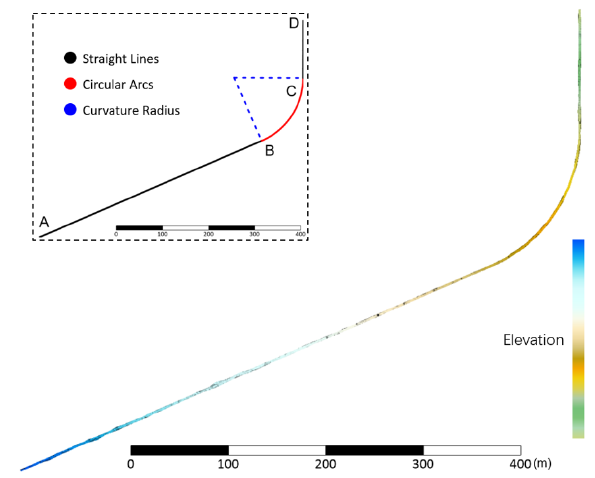
Figure 6. The reconstructed terrain model and the extracted centerline curve elements of the excavation tunnel.